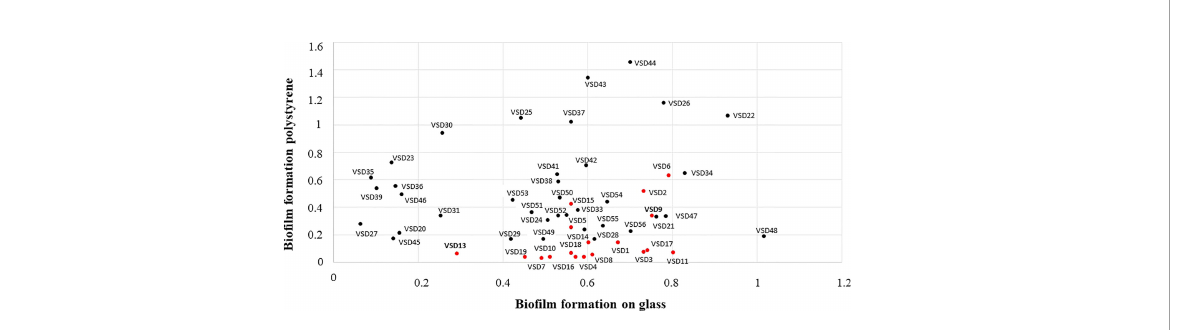
FIGURE 1 Comparison of the in vitro ability to form bio fi lms on abiotic surfaces by bovine SDSD isolates of clinical and subclinical mastitis in Portugal, during 2002-2003 (collection I, red circles) and 2011-2013 (collection II, black circles). Interpretation criteria for bio fi lm formation on polystyrene surface: i) non-producer: OD ≤ OD ctrl ; ii) weak producer: OD ≤ OD ctrl x 2; iii) moderate producer: OD ctrl x 2 < OD ≤ OD ctrl x 4; and iv) strong producer: OD>OD ctrl x 4 Interpretation criteria for in vitro bio fi lm formation on glass surface: i) non-producer: OD 600 ≤ 0.099; ii)